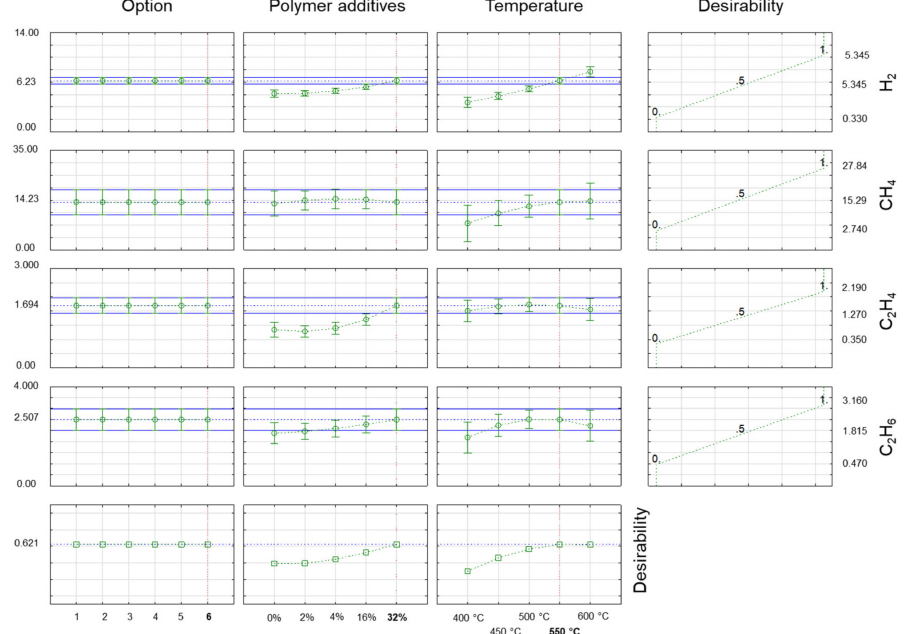
Figure 4. Desirability charts for percentage concentrations (% v / v ) of H 2 , C 3 H 8 , C 3 H 6 , and C 4 H 10 in gaseous products obtained for the optimal co-pyrolysis conditions where desirability was a percentage of target fulfilment (maximisation of essential substances in gaseous products while minimising ballast substances, e.g., CO 2 ).